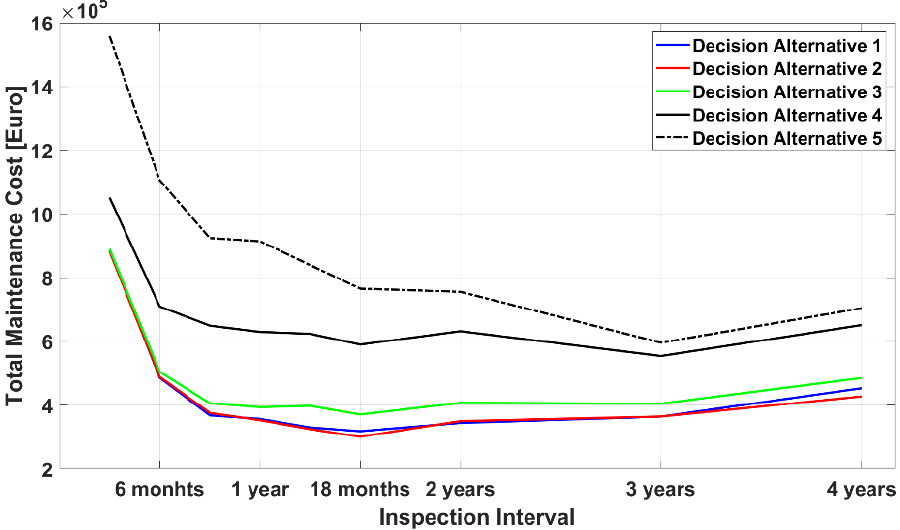
Figure 7. Cost trend as a function of inspection interval for all decision alternatives.